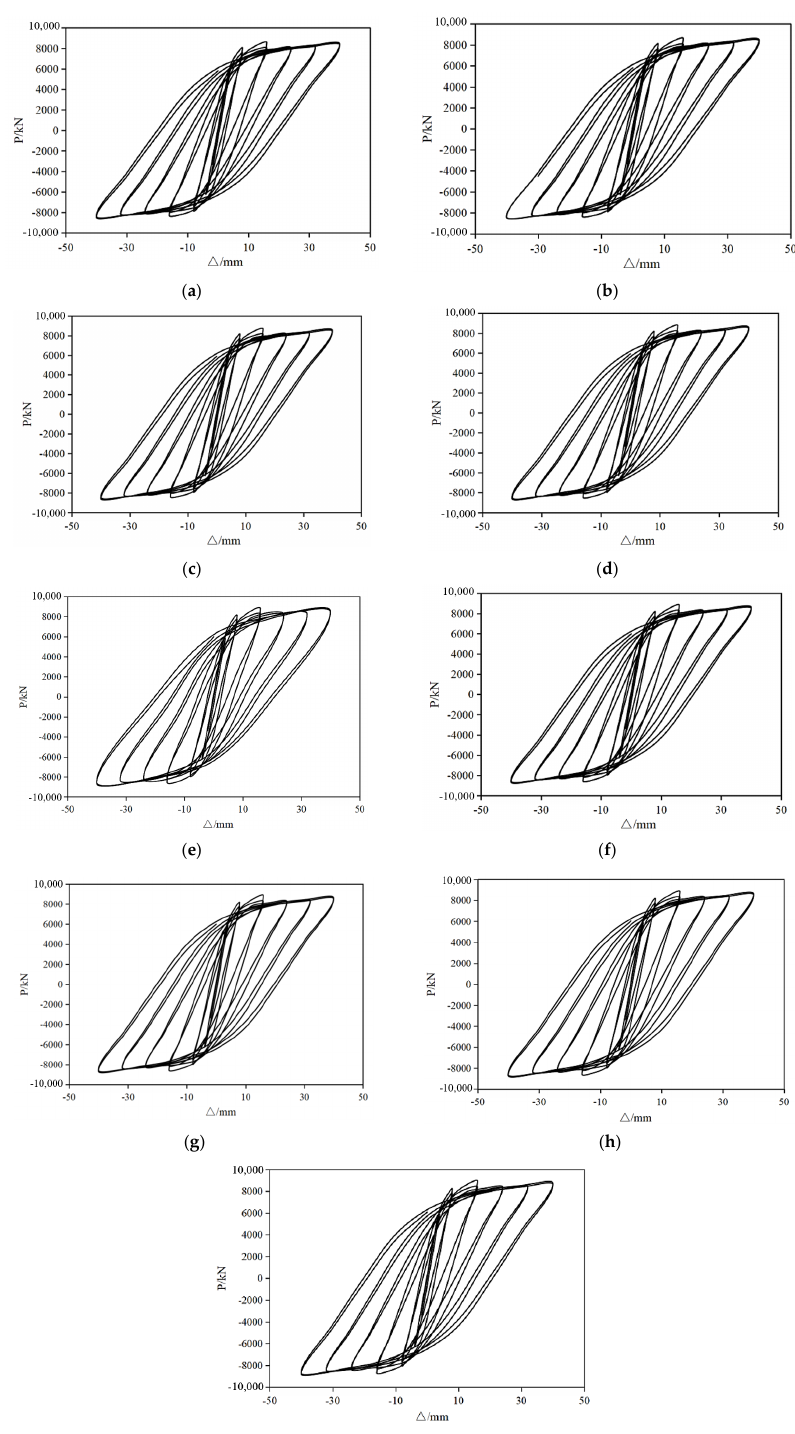
Figure 8. Hysteresis curve of models with different lap lengths. ( a ) l o = 50 mm; ( b ) l o = 75 mm; ( c ) l o = 100 mm; ( d ) l o = 125 mm; ( e ) l o = 150 mm; ( f ) l o = 175 mm; ( g ) l o = 200 mm; ( h ) l o = 225 mm; ( i ) l o = 250 mm.